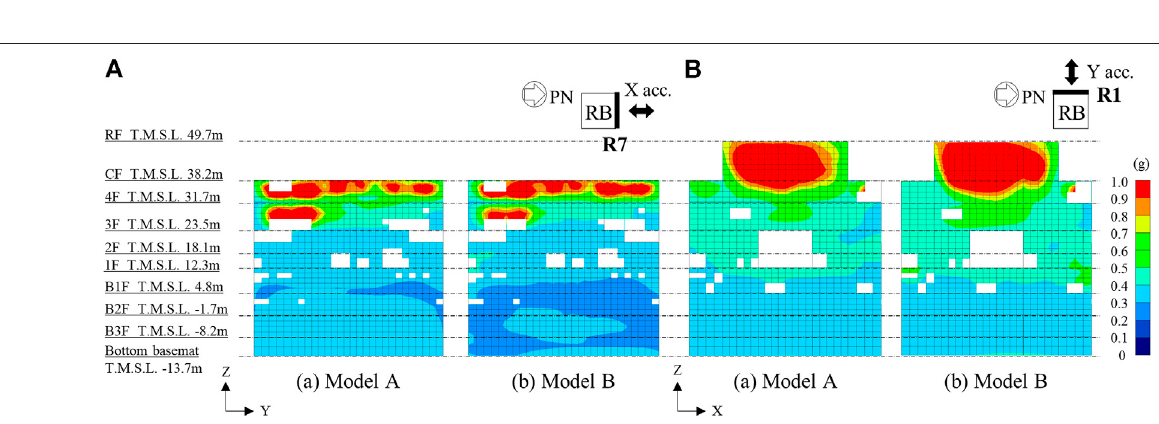
FIGURE 10 | Maximum acceleration contours in (A) NS direction for line R7 external walls (north) and (B) EW direction for line RA external walls (west).